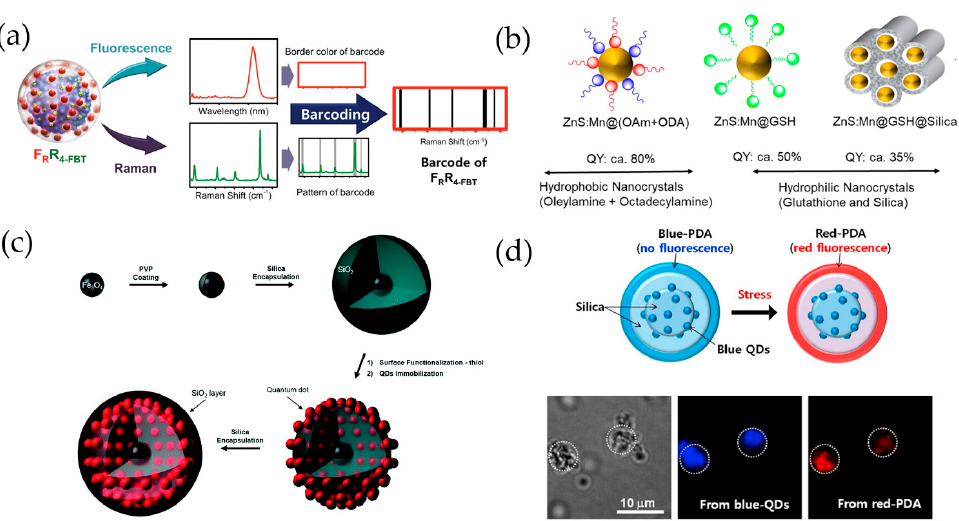
Figure 2. ( a ) Fluorescence-SERS QD-embedded silver bumpy nanoprobes, which have a SiO 2 @AgNS@SiO 2 @QD 2 @SiO 2 structure. Forty-five different dual-modal nanoprobes were prepared from silica-coated silver bumpy nanoshells (AgNS@SiO 2 ) with 15 different types of Raman label compounds and 3 types of QDs (red, green, and blue) [42]. ( b ) Mn-doped ZnS (ZnS:Mn) QDs combining dual ligands (oleylamine and octadecylamine), hydrophilic glutathione (GSH) ligands, and silica for biomedical application. Adapted with permission from ACS Appl. Nano Mater. 2020, 3, 3, 3088–3096. Copyright 2020 American Chemical Society [49]. ( c ) Dual-functional nanoprobe composed of an iron oxide core surrounded by QD-embedded silica NPs [44]. ( d ) SiO 2 @QDs@PDA NPs for label-free, multiplexed detection of biological molecules